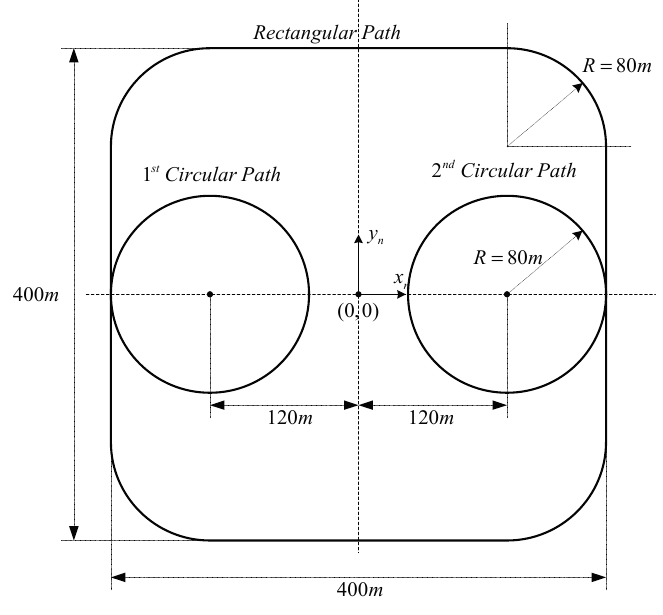
Figure 12. Path description of the integrated formation flight